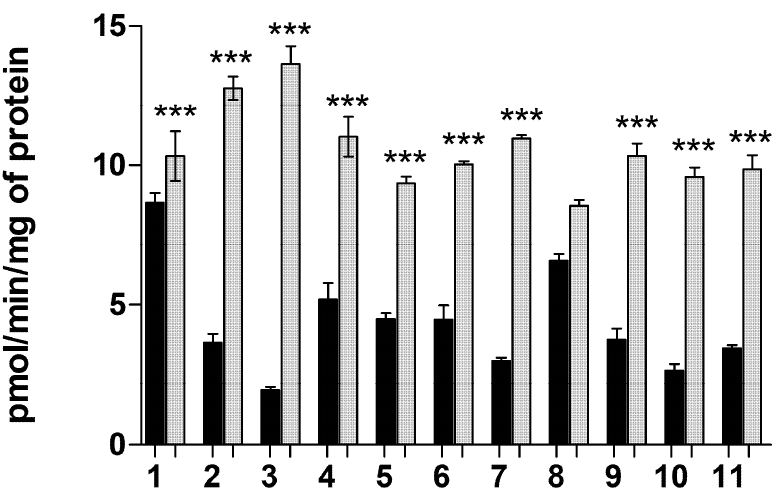
Figure 3. Cellular uptake of 25 µM compounds 1 – 11 into the MCF-7 cells at pH 7.4 (black bars) and at pH 5.5 (white bars). The data is presented as mean ± SD, n = 3 (*** p < 0.001, one-way ANOVA, followed by Tukey’s test).